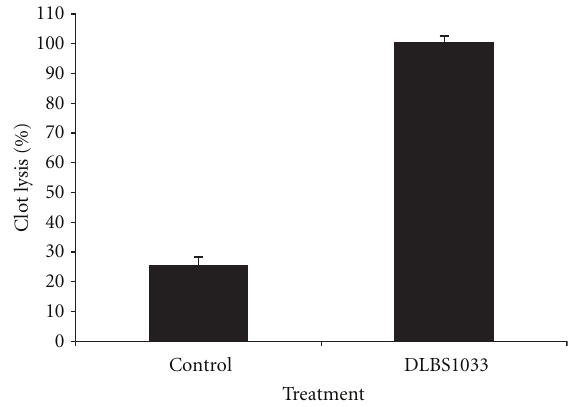
Figure 10: Lysis of blood clot by DLBS1033. Clot lysis was measured and compared between control and